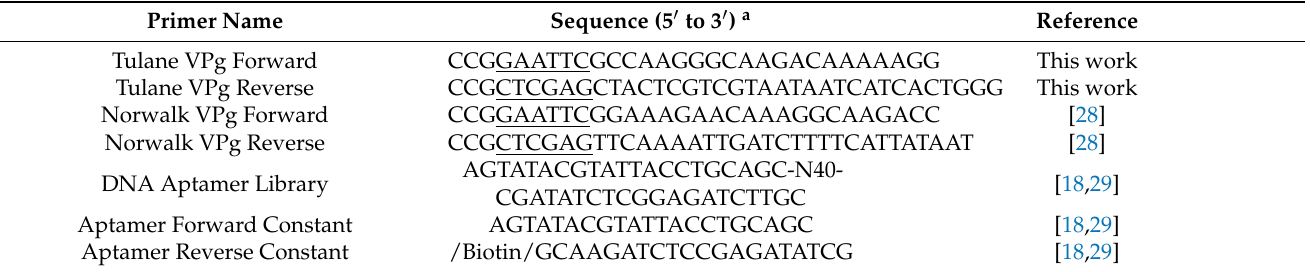
Table 1. Primers used in this